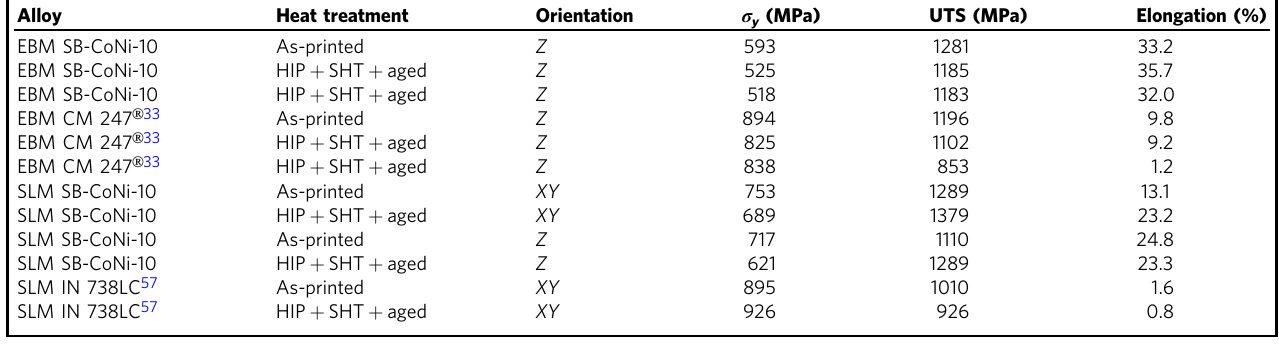
Table 2 Results of room temperature tensile testing.